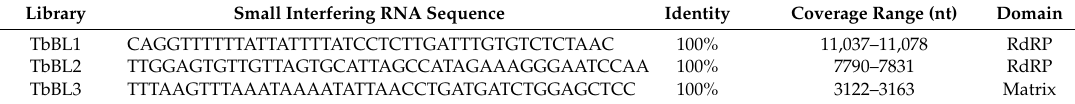
Table 3. The Blastn results of small interfering RNA against the genome of TbRV-1.